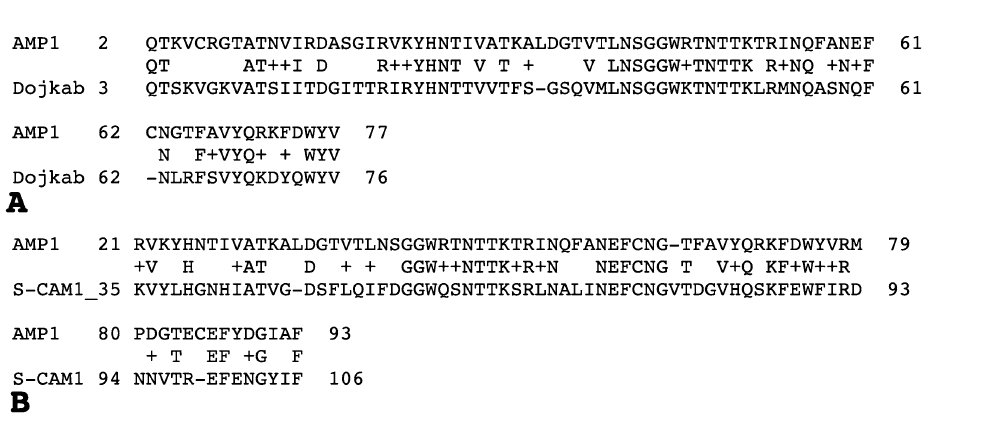
Figure 5. ( A ) BlastP alignment of the phage AMP1 ORF14 product and Candidatus Dojkabacteria bacterium protein (protein sequence ID: MBE0573628.1). ( B ) BlastP. alignment of the phage AMP1 ORF3 protein and ORF70 from the cyanobacterial myovirus